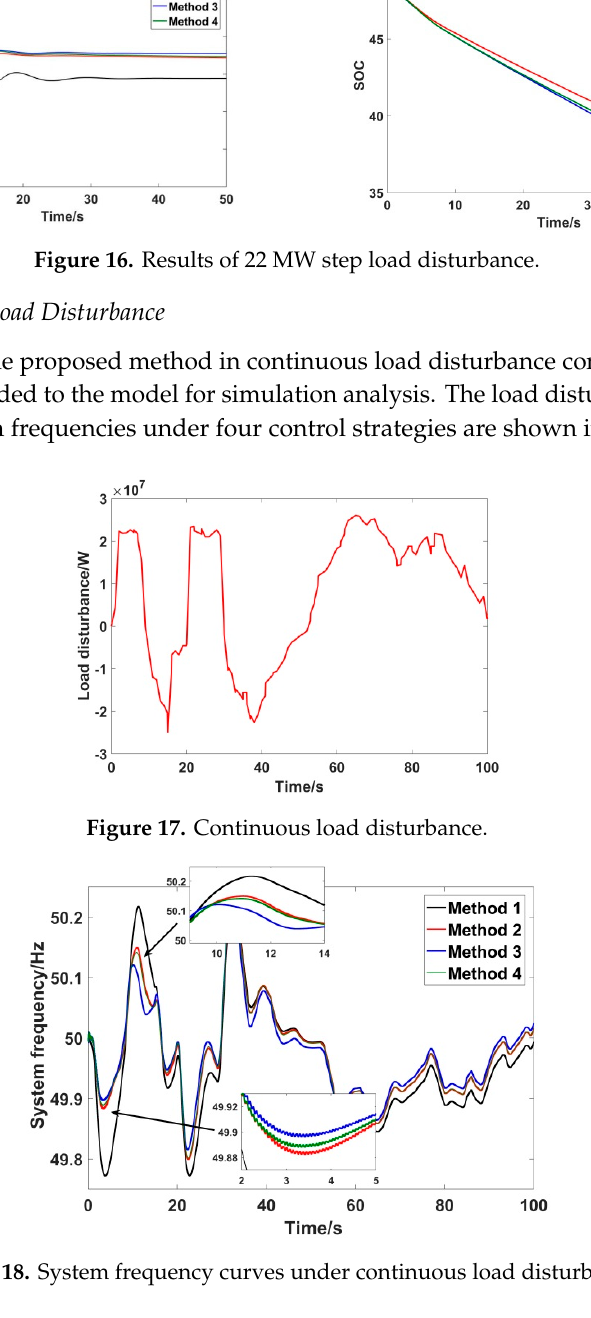
Figure 15. Results of 20 MW step load disturbance of.